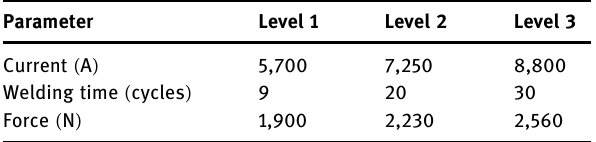
Table 2: Welding process parameters